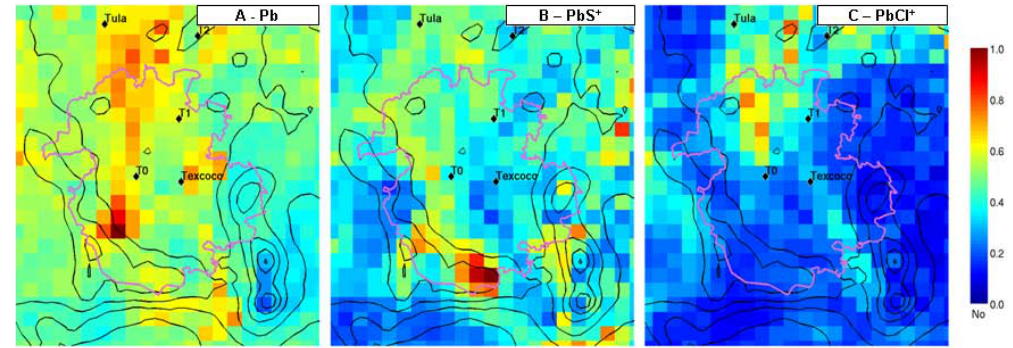
Fig. 13. Concentration Field Analysis (CFA) results for AMS Pb mass concentration – Panel (A) , and 208 PbS + – Panel (B) and 208 PbCl + (Panel C ) open signals at T0. The color scale is proportional to the probability of the presence of a source region of Pb at each location. The pink line corresponds to the limits of the Mexico City Metropolitan Area, black terrain contour lines shown every 500m.